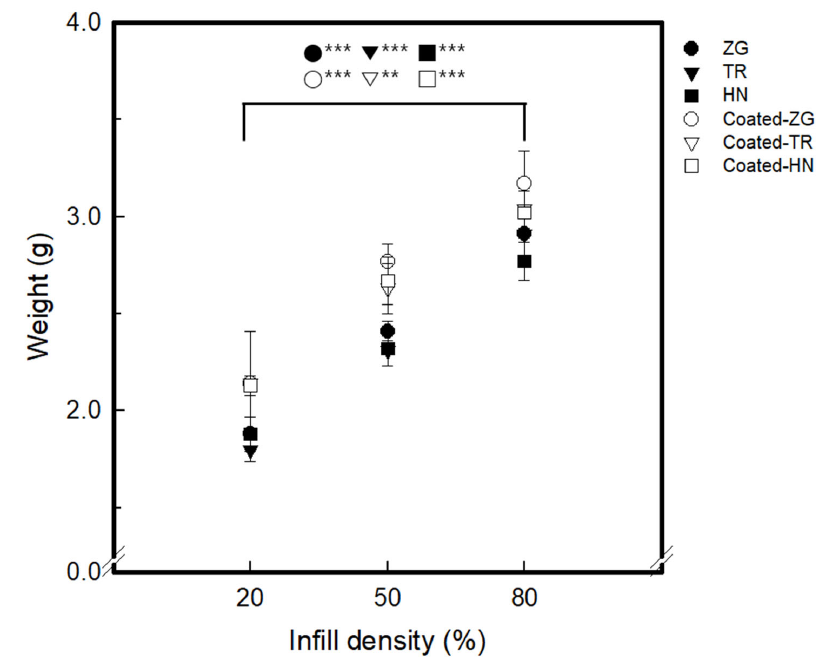
Figure 2. The weight of 3DP index fingertips and GR/WPU coated 3DP fingertips with various infill pa tt ern and density( p -value: ** p < 0.01, *** p < 0.001).